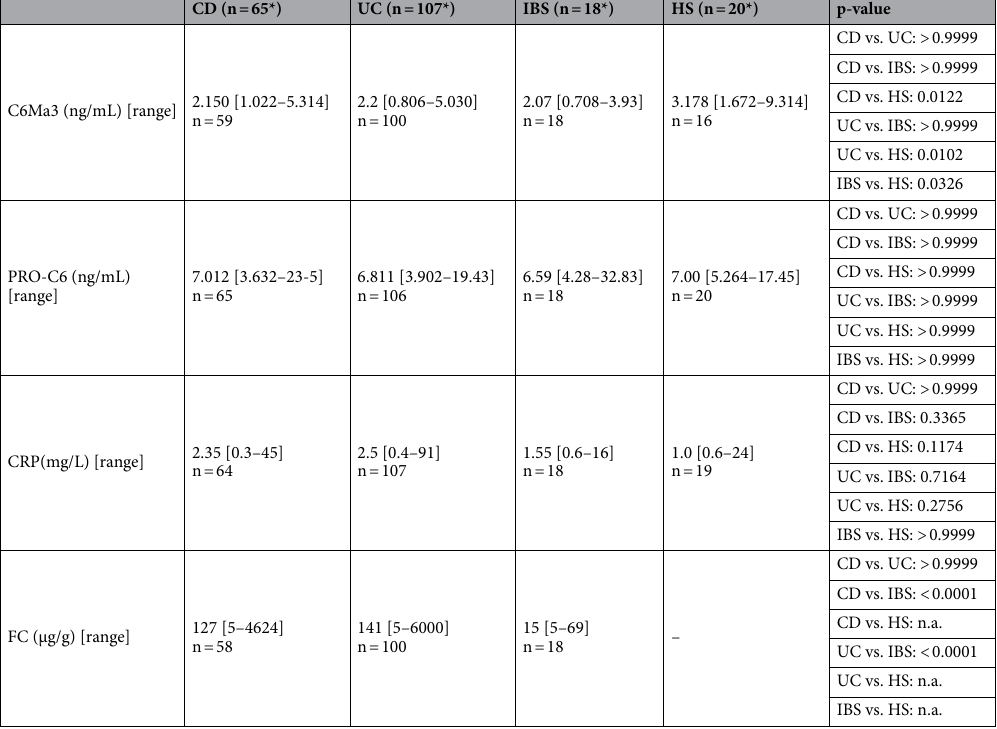
Table 2. Biomarker levels. Median values with ranges. *Changes in sample size due to missing values for the specific biochemical markers. The samples size for each biomarker is stated in the table. Differences in biomarker levels were investigated with Kruskal–Wallis. p-values adjusted with Dunn’s multiple comparisons test are presented in the table. Statistical significance was defined as p < 0.05.